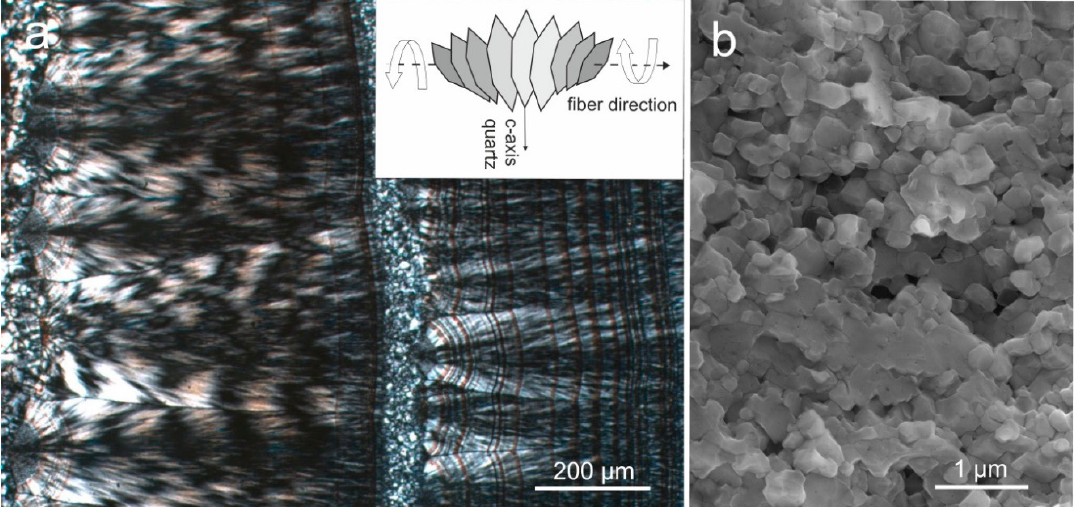
Figure 3. ( a ) Micrograph of an agate from Schlottwitz, Germany in transmitted light (crossed polars) showing chalcedony “fibers” with the characteristic “Runzelbänderung” caused by twisting of the optical axis of the quartz crystallites oriented with their c ‐ axes perpendicular to the “fiber” axis; the inset schematically shows the formation of chalcedony “fibers”; ( b ) SEM micrograph of the same area revealing numerous quartz microcrystals <1 μ m in size.